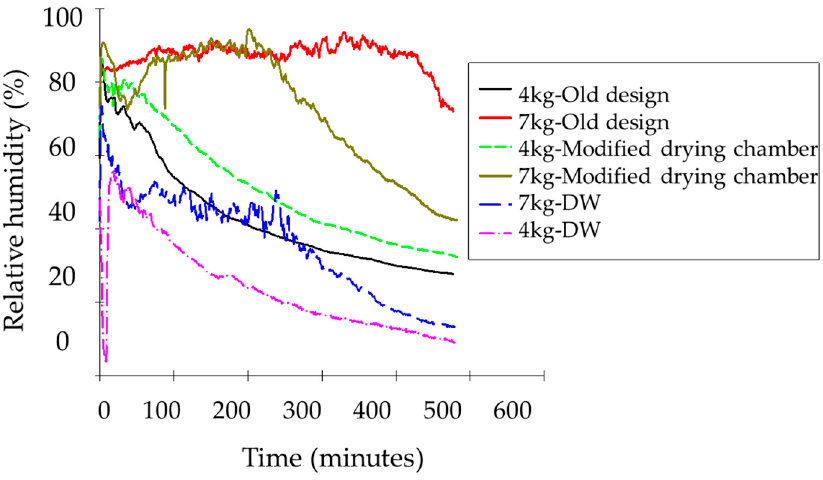
Figure 8. Variation in the relative humidity at the dryer